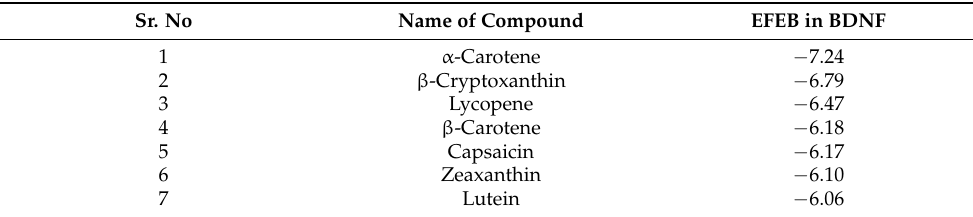
Table 7. Docking score (EBEF) of the selected carotenoids with